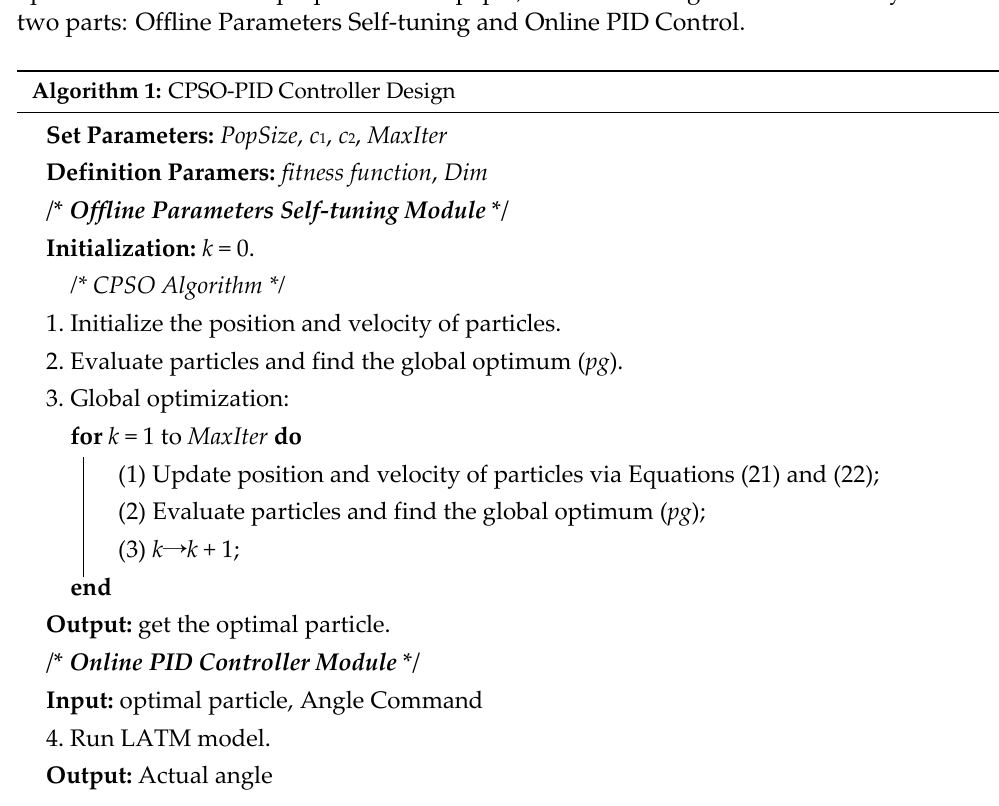
Figure 9. Triple closed loop cascade PID control of LATM based on CPSO algorithm. Algorithm 1: CPSO-PID Controller